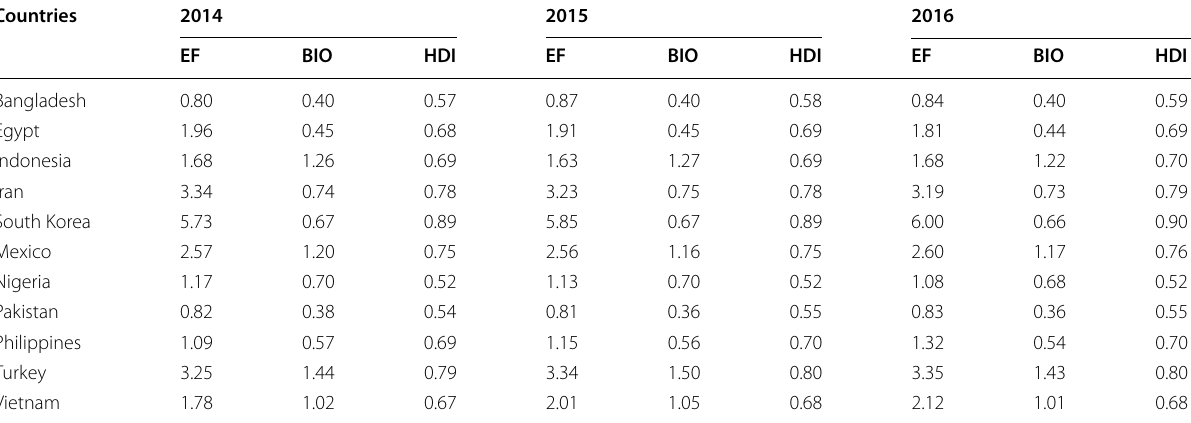
BIO biocapacity